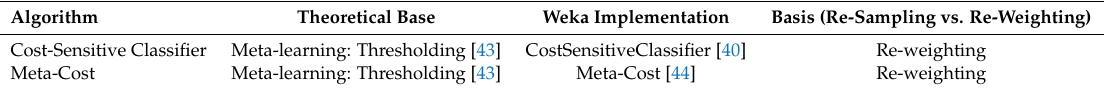
Table 3. Employed Cost-sensitive analysis algorithms